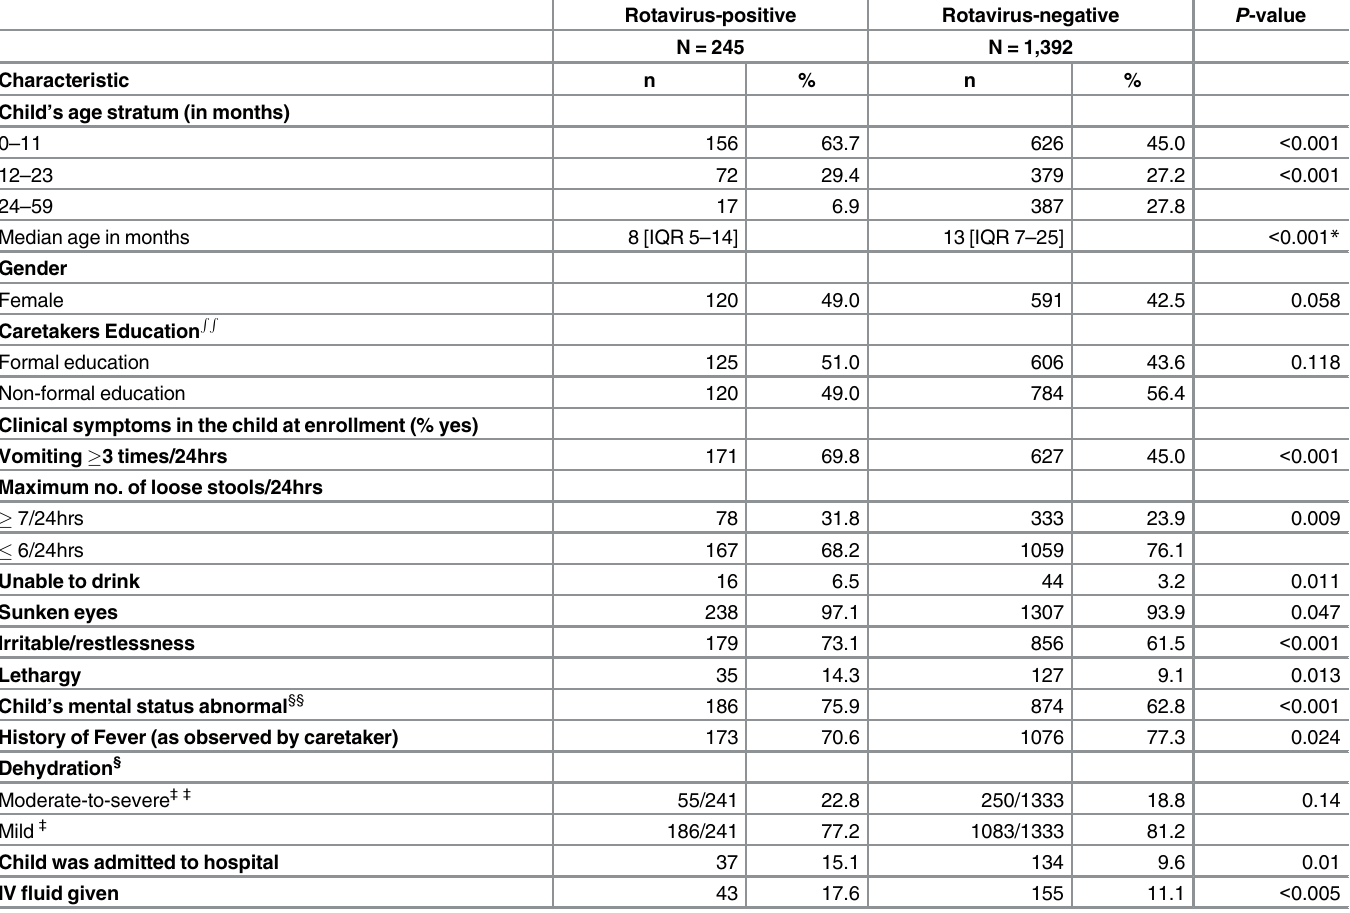
Table 2. Bivariate analysis of baseline characteristics of children with rotavirus-positive and rotavirus negative non-dysenteric MSD (n = 1637), western Kenya, 2008 –